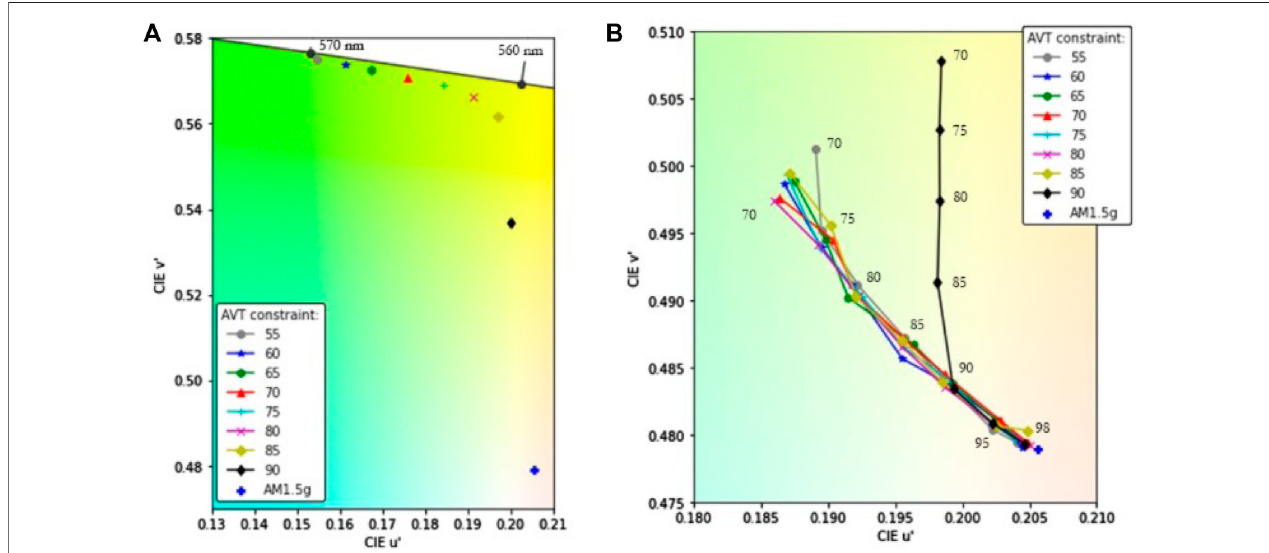
FIGURE8| Zoom-inof Figure7 . (A) u ’ andv ’ valuesontheCIE1976colorimetricdiagramfortheoptimisedluminophore,constraintonlybyAVTvalues. (B) u ’ and v ’ values on the CIE 1976 colorimetric diagram for the optimised luminophore constraint by AVT and CRI. The numbers indicate the CRI value of the points closest. u ’ v ’ results for AVT values between 85 and 90 (not shown) lie between the results of AVT 85 and 90.